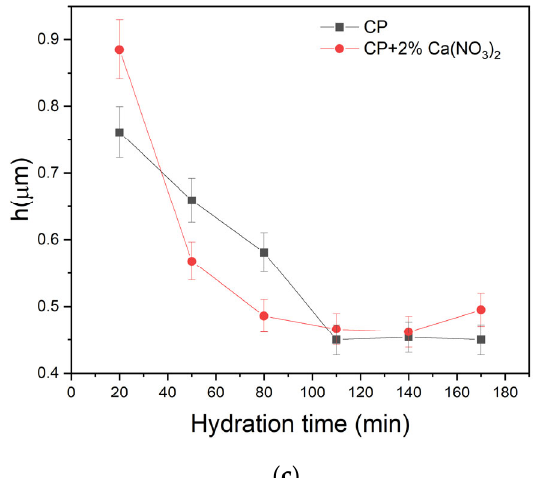
Figure 4. The fitting parameters, extracted from the data in Figure 3 by using the 3 ‐ Tau model. ( a ) Number density of paramagnetic ions versus hydration time. ( b ) The ratio the ratio between the volume of the surface layer and the pore volume versus hydration time. ( c ) The pore size versus hydration time in the approximation of plane pores.